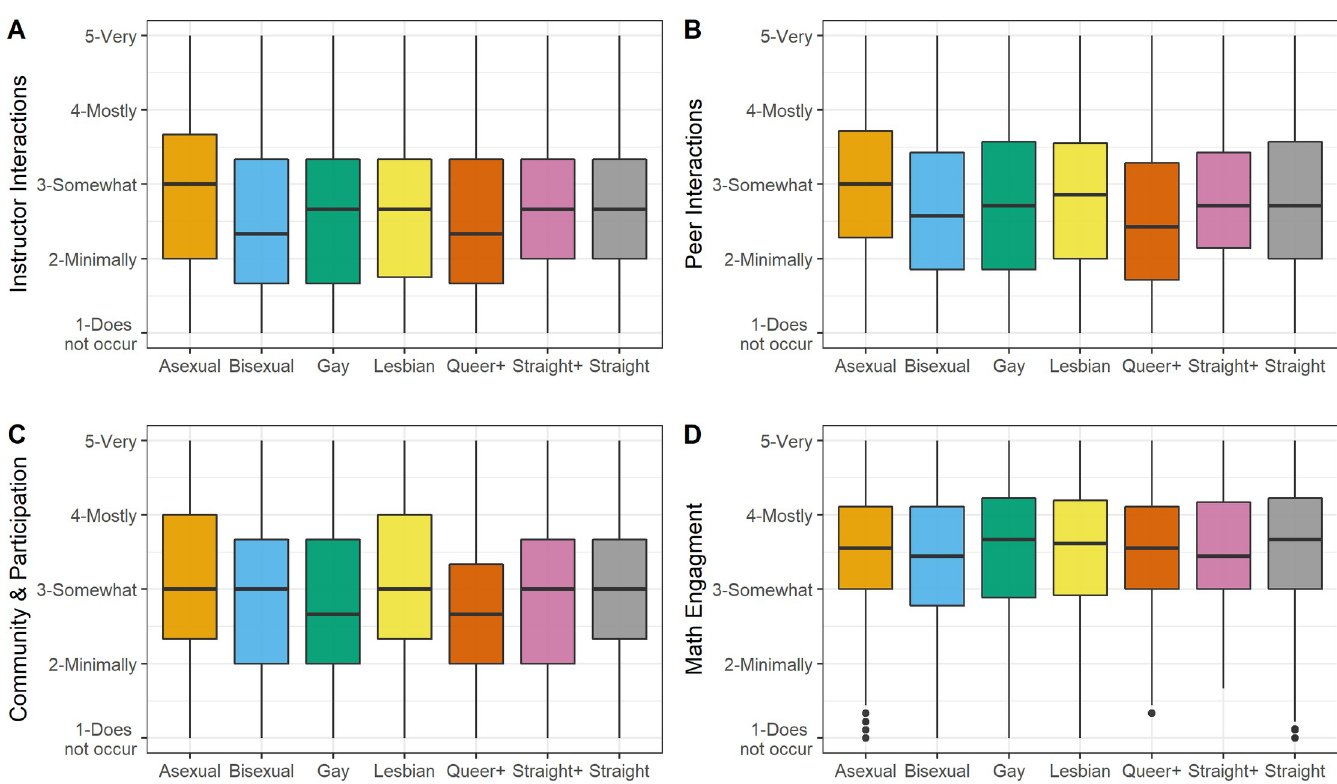
Fig 3. Boxplot with mean of Instructor interactions (A), Peer Interactions (B), Community and Participation (C), and Math Engagement (D) across sexual identity. https://doi.org/10.1371/journal.pone.0275325.g003 significant with higher levels for Asexual students ( M = 2.97, SD = 1.01) compared to Gay (M = 2.72; SD = 1.08), Queer+ (M = 2.60; SD = 1.03), Bisexual (M = 2.70; SD = 1.03) and straight (M = 2.78; SD = 1.00) students. For Community & participation , responses for Asexual students ( M = 3.15 SD = 1.05) and straight students (M = 3.04 SD = 1.04) were pair-wise statis- tically significantly compared to Gay (M = 2.86; SD = 1.08), Queer+ (M = 2.81; SD = 0.95), and Bisexual (M = 2.91; SD = 1.07) students. For Math engagement , a statistically significant difference in mean score for Bisexual students ( M = 3.42, SD = 0.91) was lower compared to straight (M = 3.55; SD = 0.87) students.